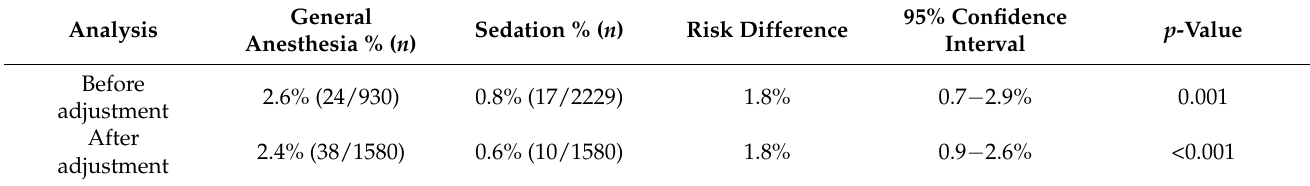
Table 3. Comparison of the proportion of patients with severe complications between the general anesthesia and sedation groups, before and after adjustment by overlap weighting using propen- sity